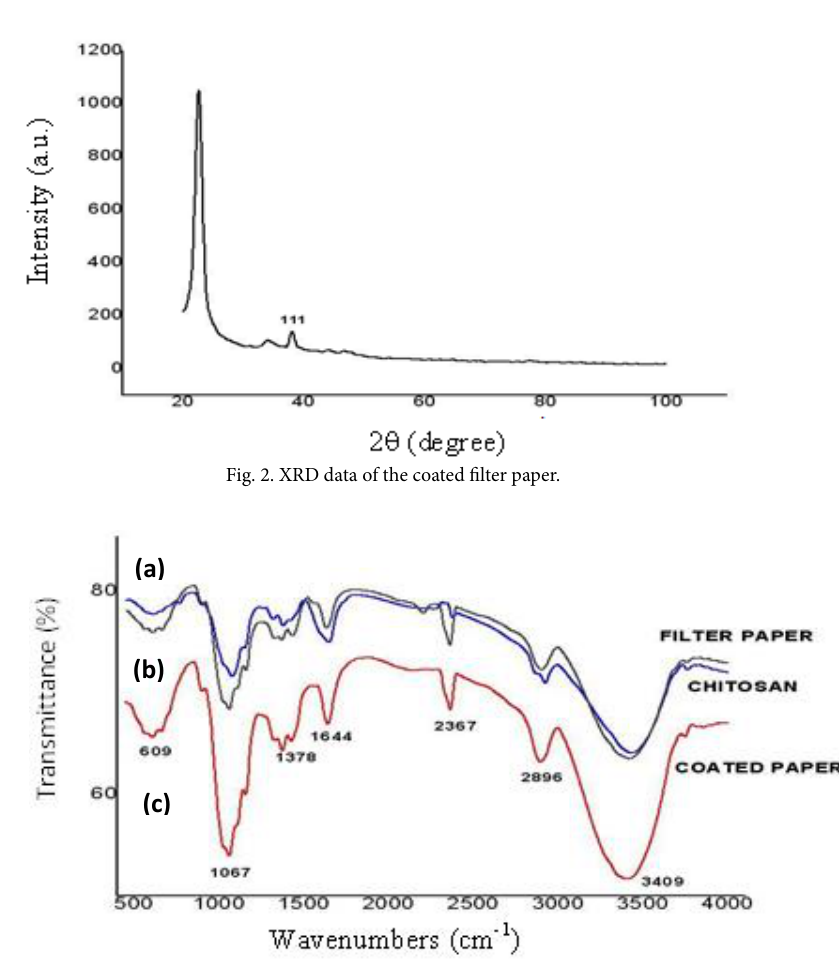
Fig. 3. IR data for ordinary filter paper, chitosan and coated filter